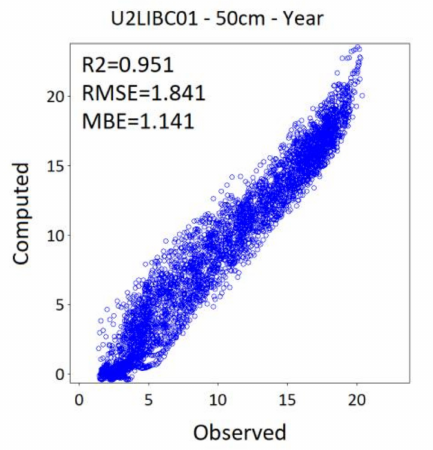
Figure A18. Validation at site U2LIBC01 for 50 cm soil